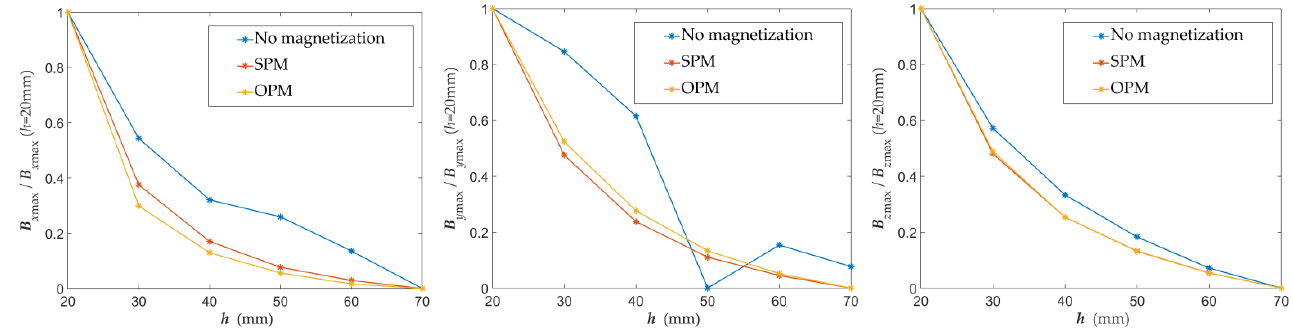
Figure 19. Graphs of the normalized maximum values of the magnetic field components as a function of the concrete cover thickness h obtained for various magnetization methods.